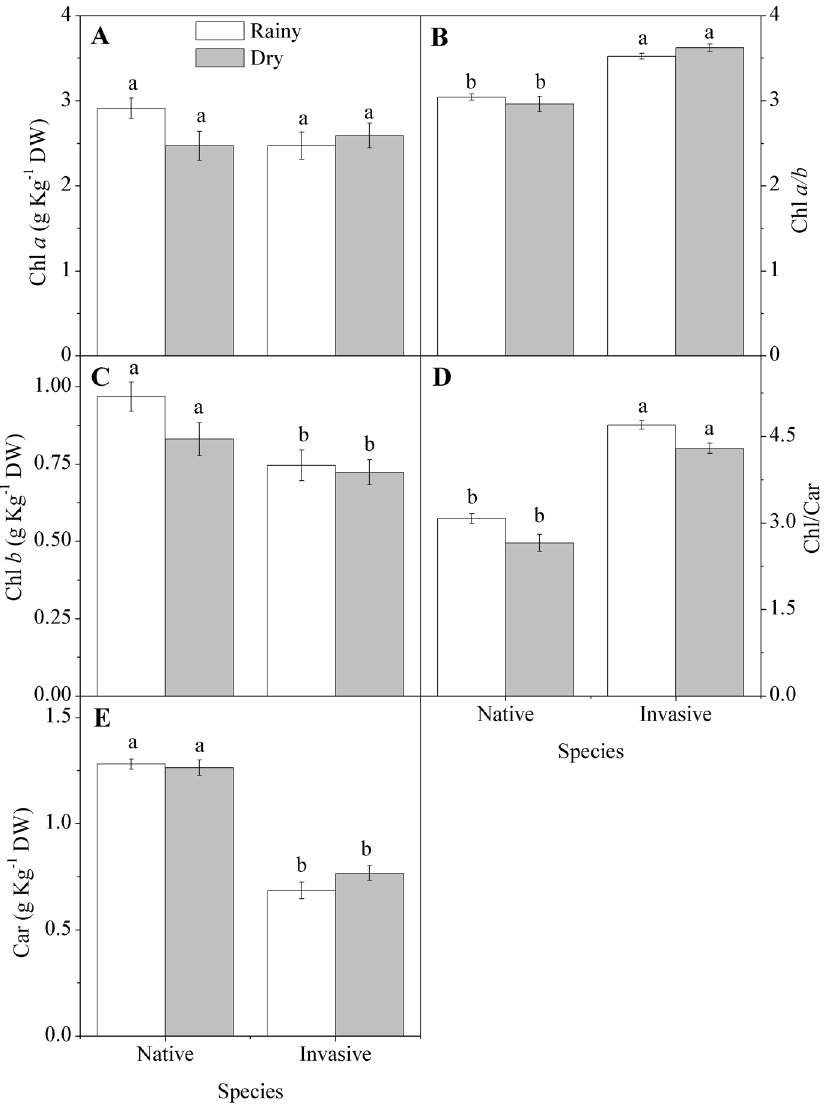
Figure 3. Concentration of leaf pigments in native ( Anadenantheracolubrina) and invasive ( Prosopisjuliflora ) species in a tropical dry forest in Brazil across seasons: (A) chlorophyll a (Chl a ); (B) chlorophyll a / b (Chl a / b ); (C) chlorophyll b (Chl b ); (D) chlorophyll/ carotenoids (Chl/Car); (E) carotenoids (Car). Values represent the average of replicates (n=20 6 SE; invasive dry season n=25 6 SE). Different letters denote statistical differences by Newman-Keul test with significance level of 5 percent between